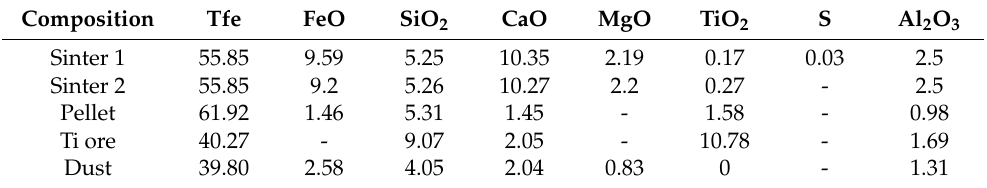
Table 3. Chemical composition of raw material and dust, w / w %.